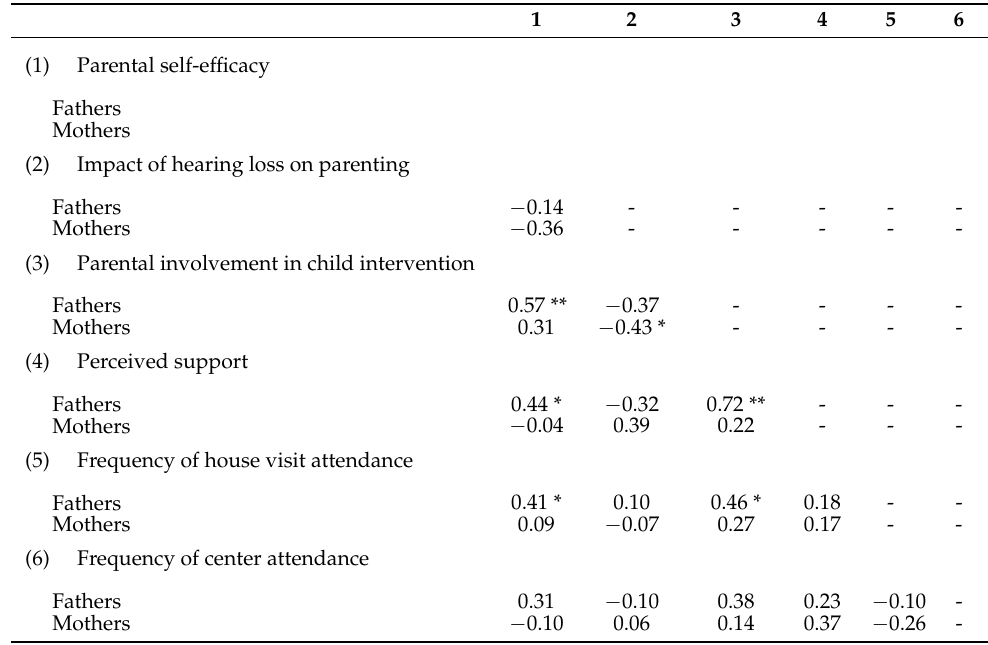
Table 6. Spearman correlations between parental self-efficacy, impact on parenting, involvement in intervention, and perceived